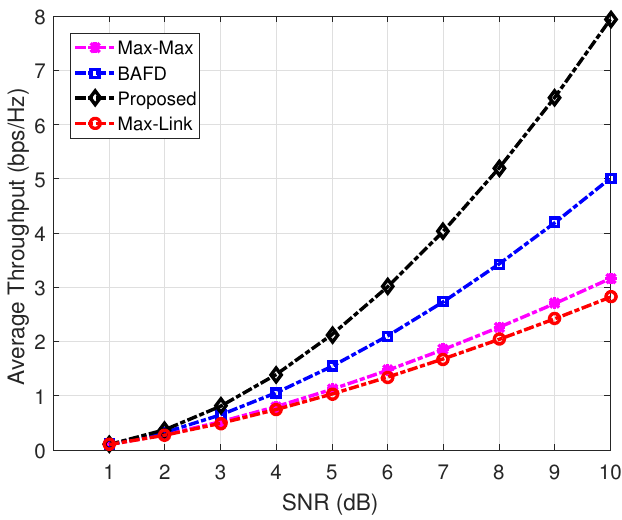
Figure 16. Average throughput vs.